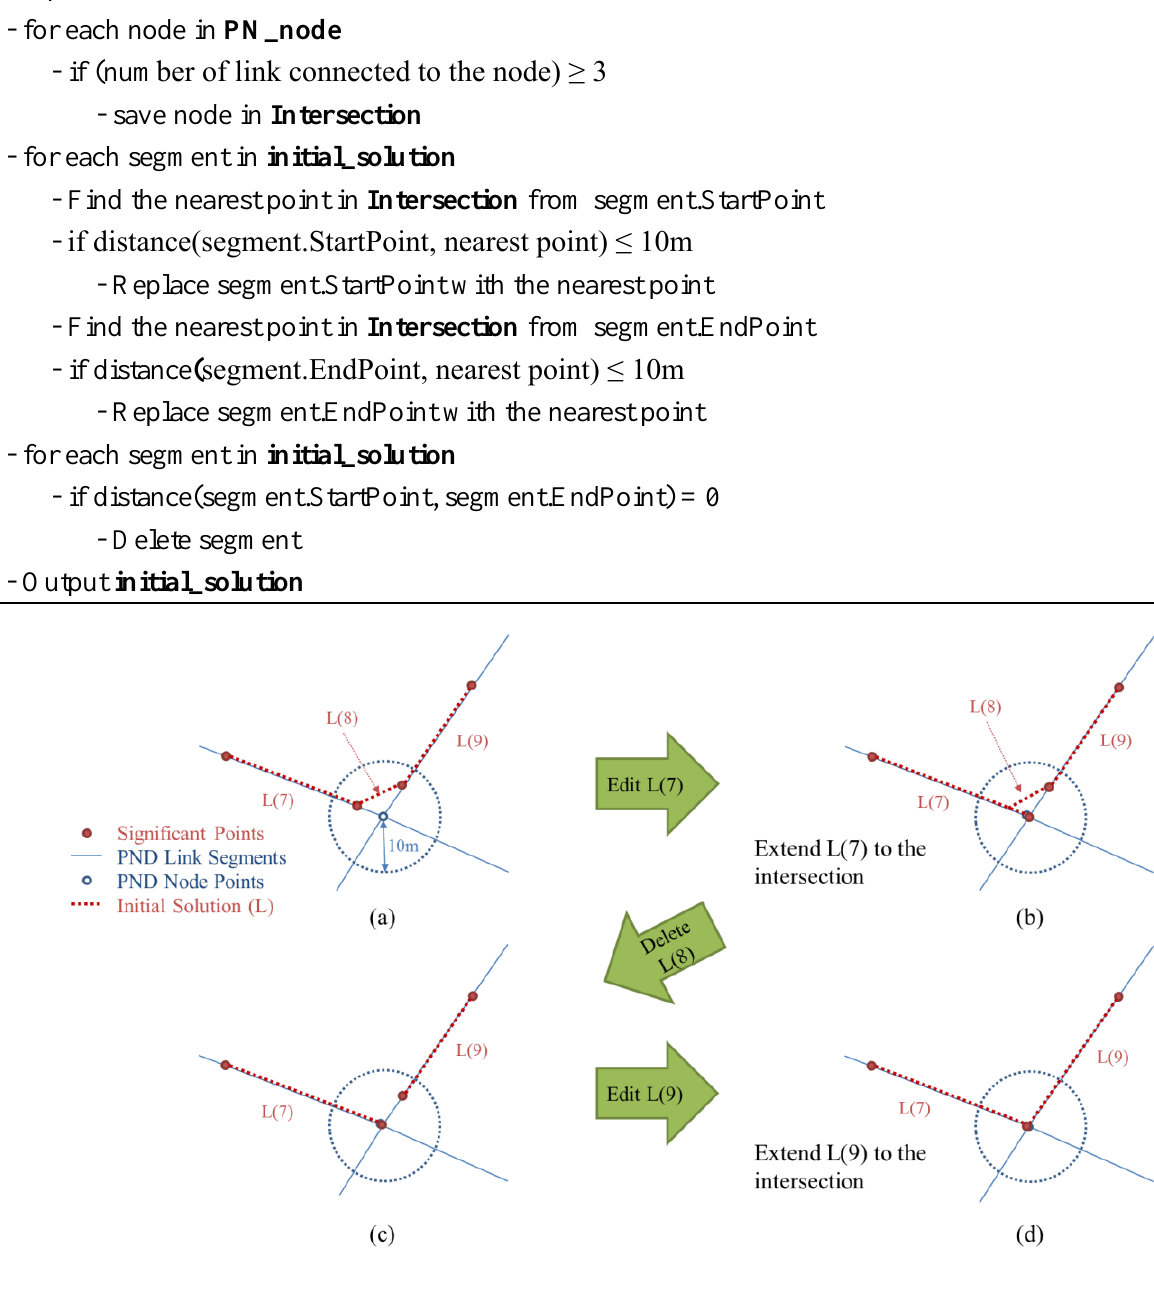
Figure 6. Process for correcting errors near the intersections: ( a ) Extract segments if their start or endpoints are near the intersections; ( b ) Extend the segment to the intersection; ( c ) Delete segments completely inside the buffer; ( d ) All segments are now extended to the